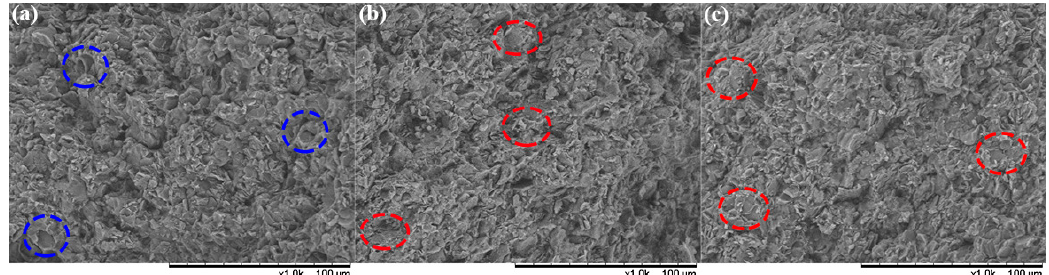
Figure 10. SEM pictures of fracture surfaces for TATB-based PBXs: ( a ) TF, ( b ) TPPF-0.5, and ( c ) TPPF-5.